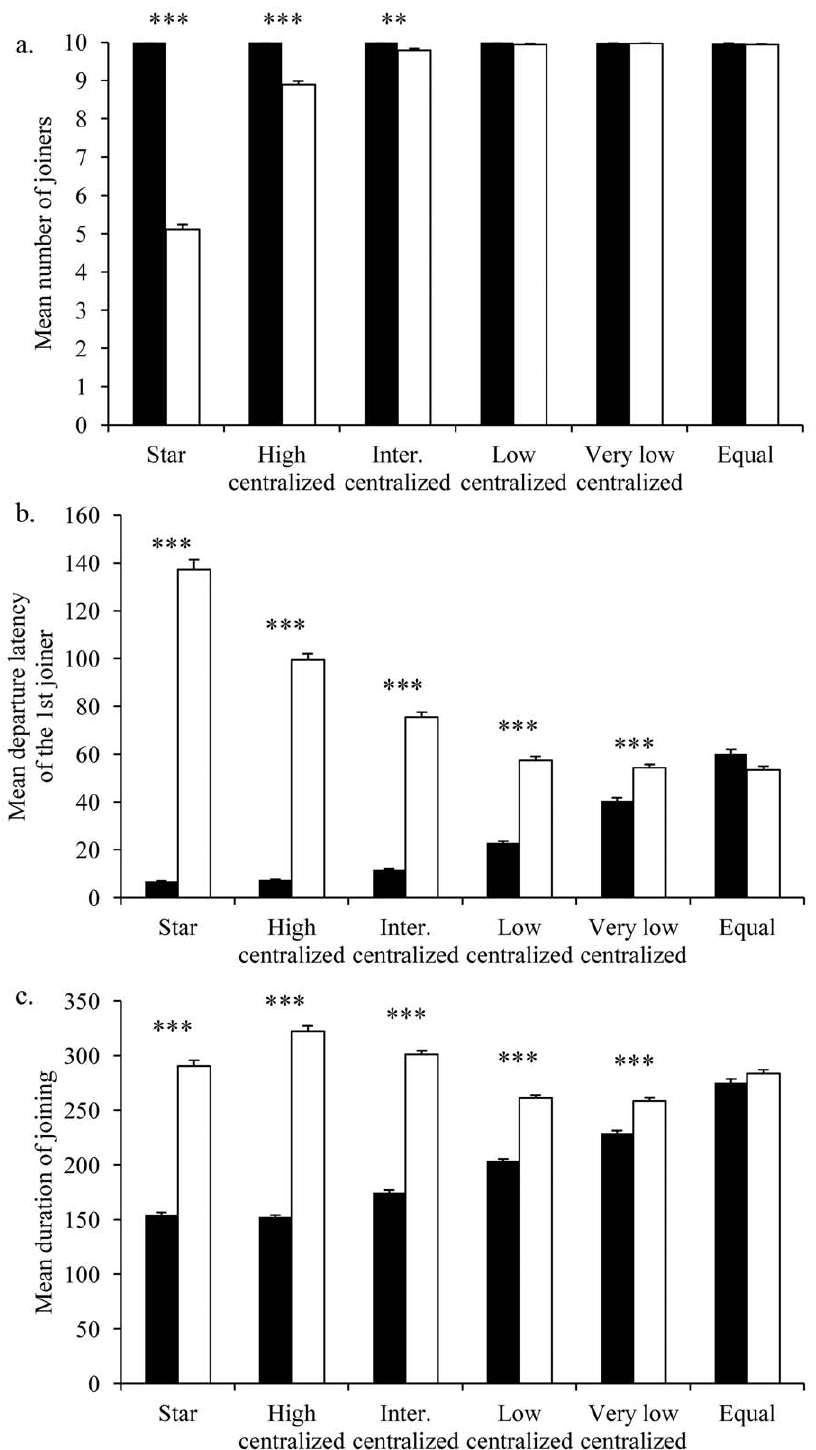
Figure 3. Comparison between the central individual and the non central individuals. (a) Mean number of joiners, (b) mean departure latency of the first joiner, and (c) mean joining duration for each social network. Central individual is represented by the black bars, non central individuals are represented by the white bars.